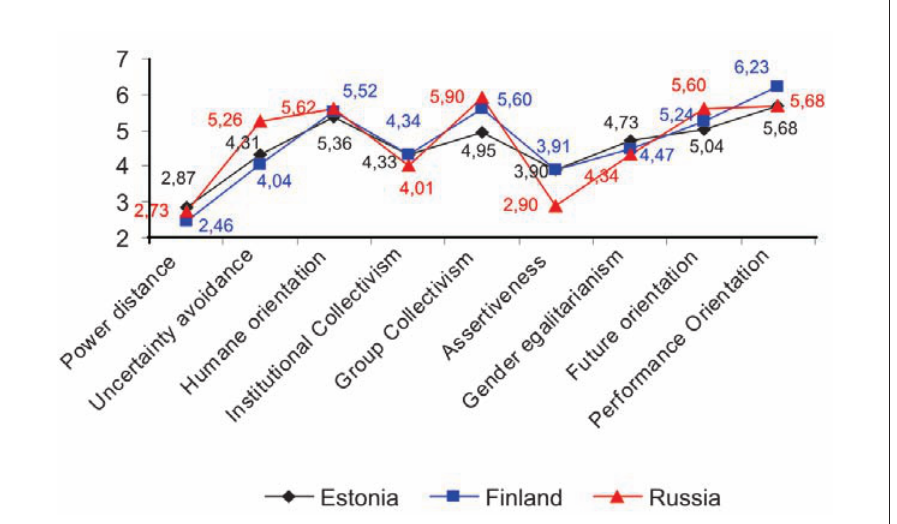
Fig 2. Comparison of societal values in three